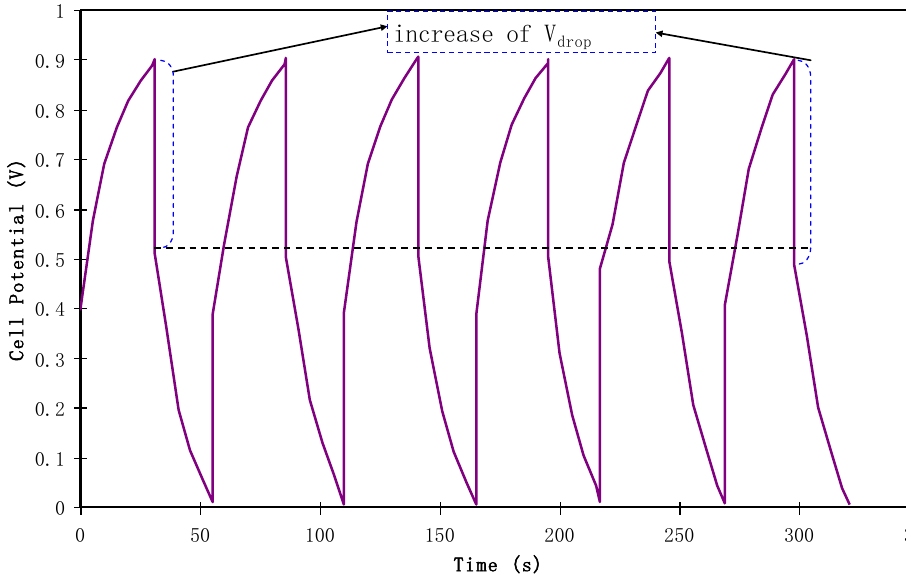
Figure 10. Charge-discharge profile for the fabricated EDLC at 0.5 mA/cm 2 . Table 2. Carbon-based EDLC studies.